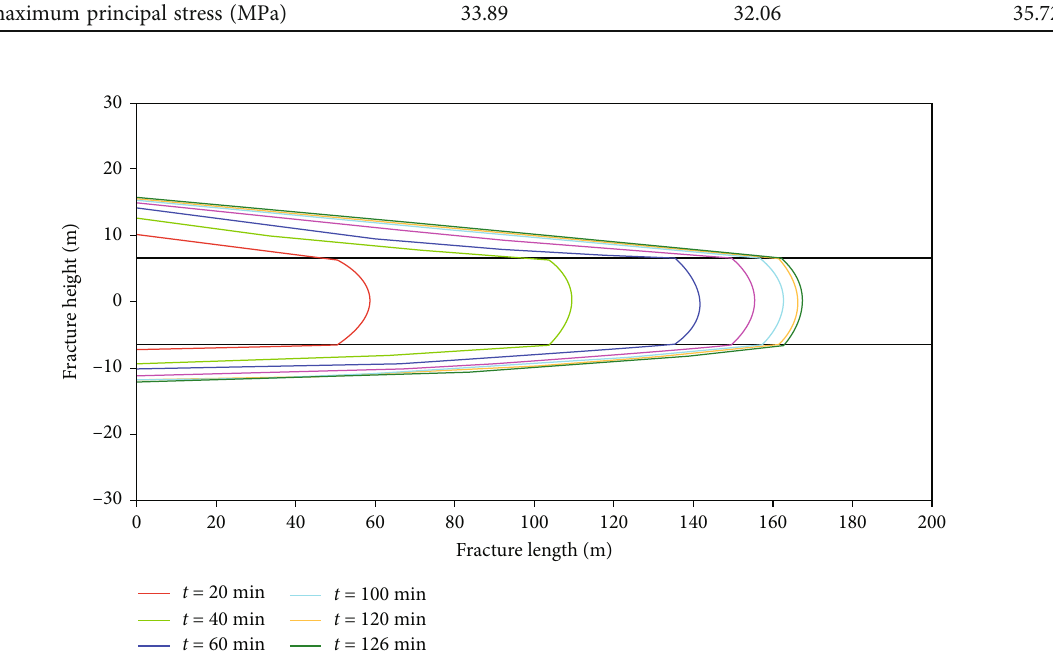
Figure 7: Fracture height pro fi le